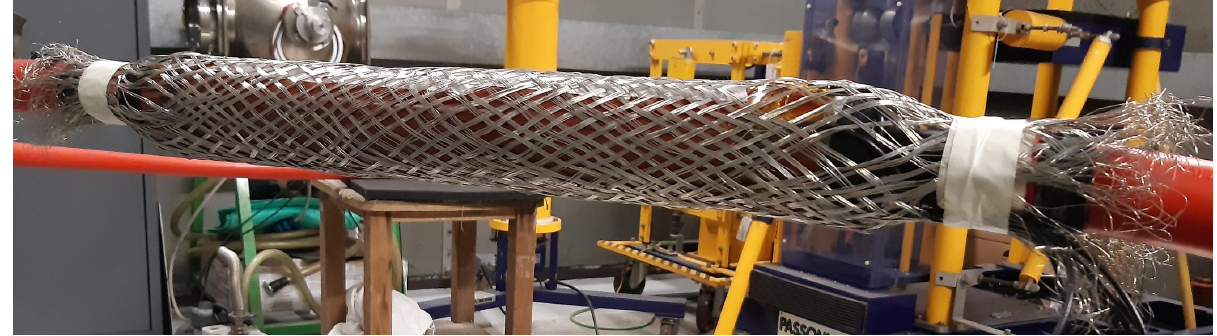
Figure 6. Placement of the PD sensor and the ground shield on the joint.